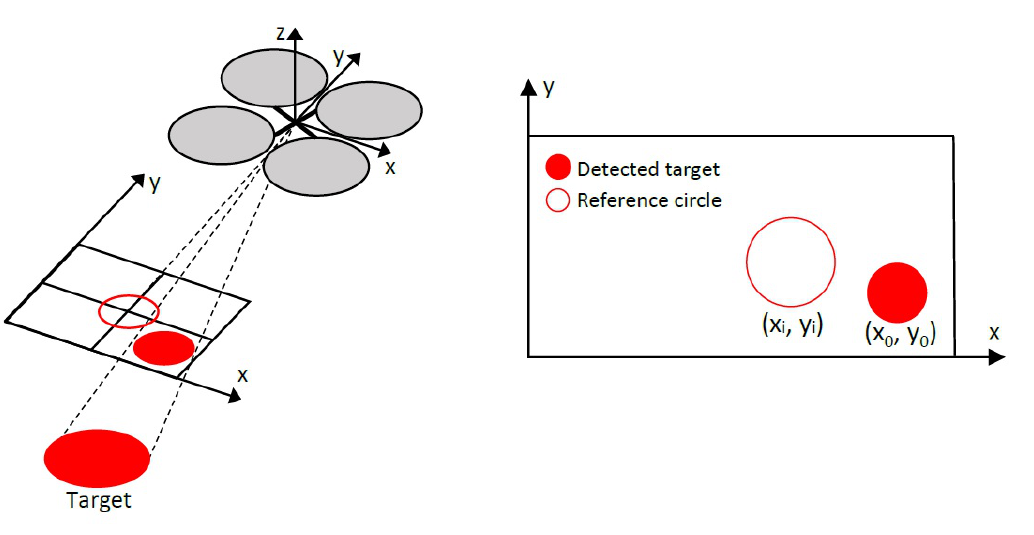
Figure 9. ( Left ) Unmanned aerial vehicle and circular red target; ( right ) target and reference position in image frame.